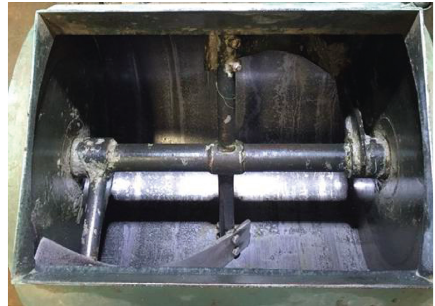
Figure 2: The single-shaft mixer used in the